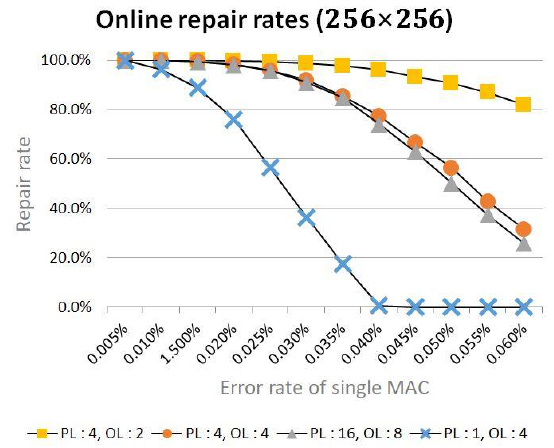
Figure 10. Online repair rate comparison with various PL s and OL s.